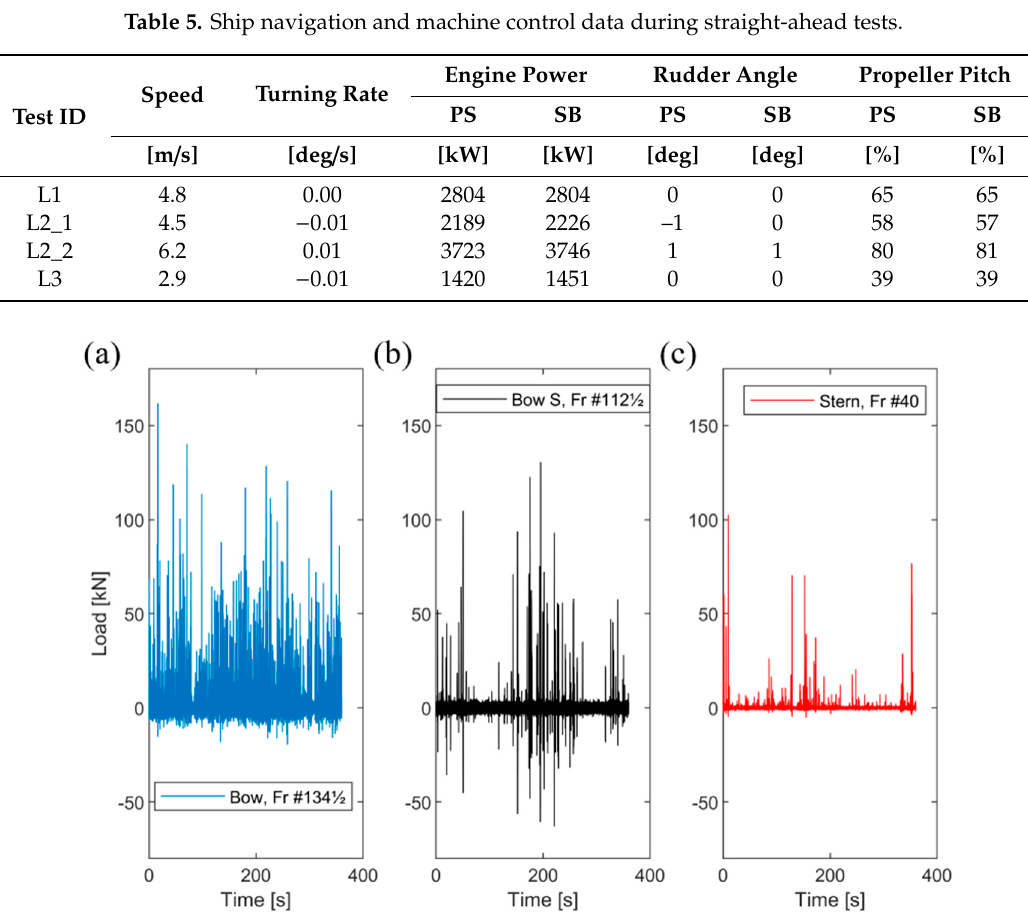
Figure 7. Measured ice-induced loads at ( a ) bow, ( b ) bow shoulder, and ( c ) stern shoulder during test L1.